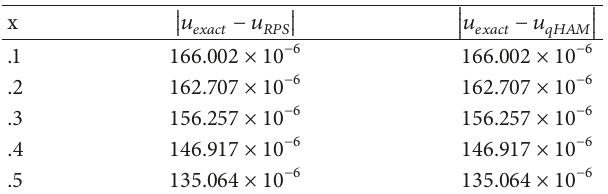
Table 2: The absolute errors |𝑢 𝑒𝑥𝑎𝑐𝑡 − 𝑢 4 | for Cahn-Hilliard when 𝑡 = .2, 𝛼 󳨀→ 1. x